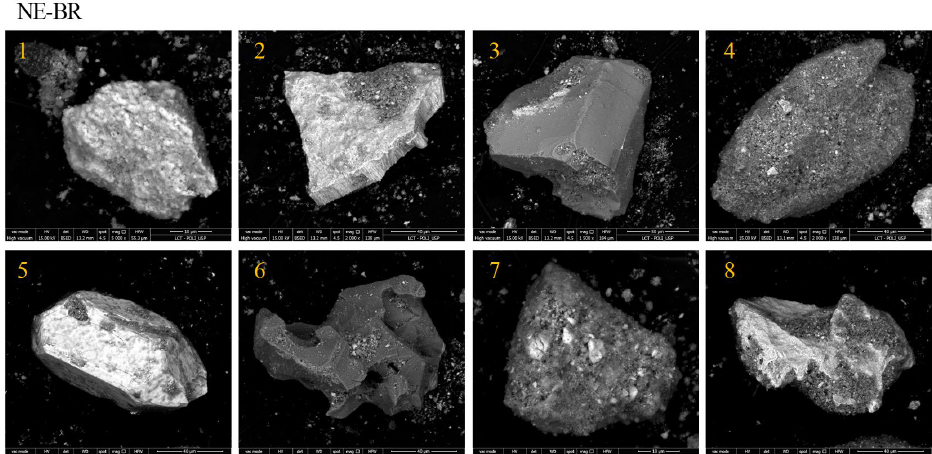
Figure 4 S EM images of NE-BR. EDS illustrates the presence of: 1 - Fe, Al, Si; 2 - Fe; 3 - Ca, Si, Al, Mg; 4 and 7 - Fe, Al, Si, Na, Ti; 5 – Zr, Si, Al, Fe, Na; 6 - Si; 8 - Al, Si, Na